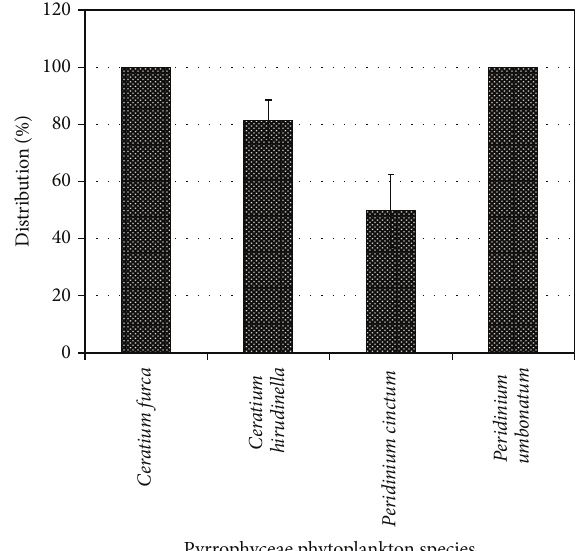
Figure 12: Overall mean values of Pyrrophyceae species in Okpoka